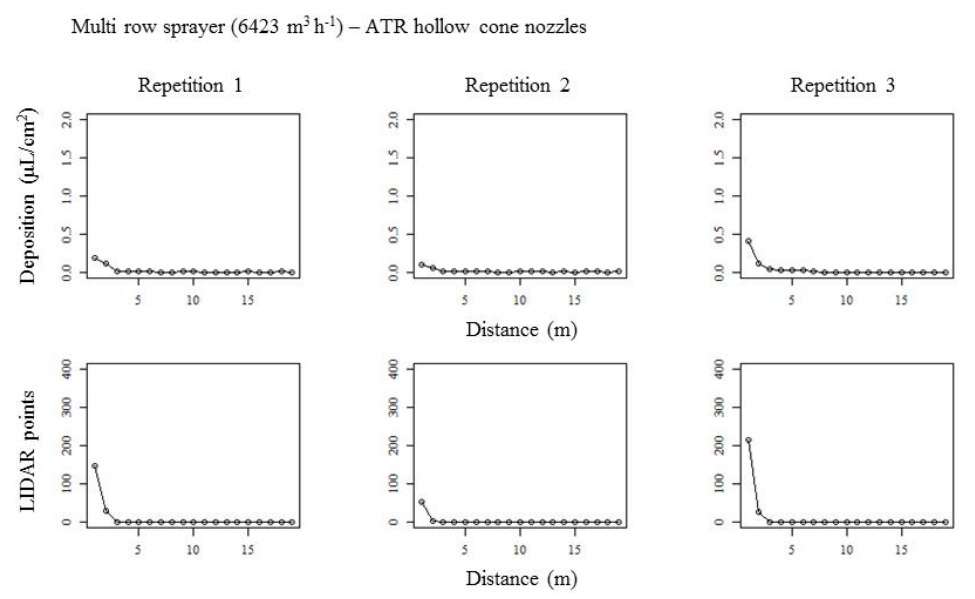
Figure 12. Curves of spray deposit (test bench and LIDAR) obtained with multi-row sprayer equipped with conventional hollow cone nozzles. Upper part of the figure represents the curves in test bench and lower part the curves obtained after LIDAR